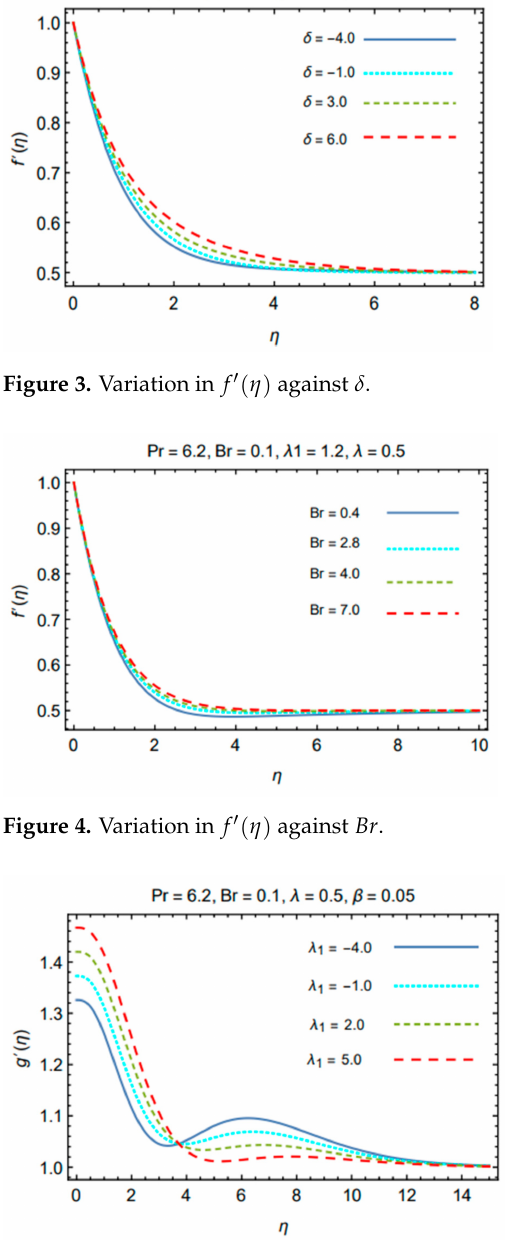
Figure 5. Variation in g (cid:48) ( η ) against λ 1